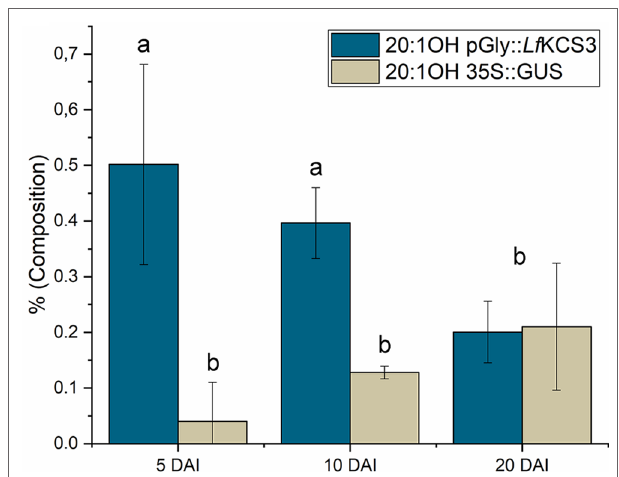
FIGURE 5 | Variation in the castor endosperm lesquerolic acid content induced by transient expression of L. fendleri β-ketoacyl-CoA synthase. The data correspond to the endosperm harvested 5, 10, and 20 days after injection (DAI), and they are the average of up to 4-6 injections ± the standard deviation. The data are the average ± the standard deviation corresponding to 4 endosperms harvested at 5, 10, and 20 days after injection (DAI). Letters indicate statistically significant differences (one-way ANOVA 0.05% significance